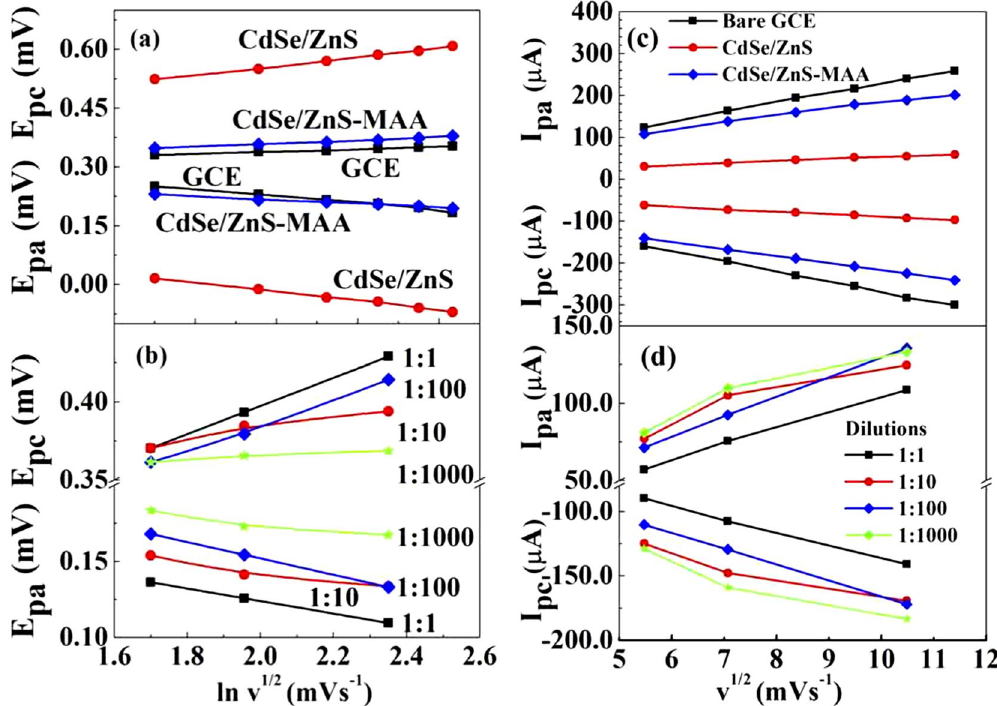
Figure 4. ( a ) E pa and E pc as a function of ln √ v /mVs −1 for GCE (black cline), QDs (red line) and MAA-QDs (blue line) modified GCE. (b) E pa and E pc as a function of ln √ v /mVs −1 for ( a ) 1:1, ( b ) 1:10, ( c ) 1:100, and ( d ) 1:1000 COx conjugated MAA-CdSe/ZnS QDs modified GCE. ( c ) I pa and I pc as a function of √ v /mVs −1 for GCE (black line), QDs (red line) and MAA-QDs (blue line) modified GCE. ( d ) I pa and I pc as a function of √ v /mVs −1 for 1:1 (black line), 1:10 (red line), 1:100 (blue line), and 1:1000 (green line) dilutions COx-MAA-QDs modified